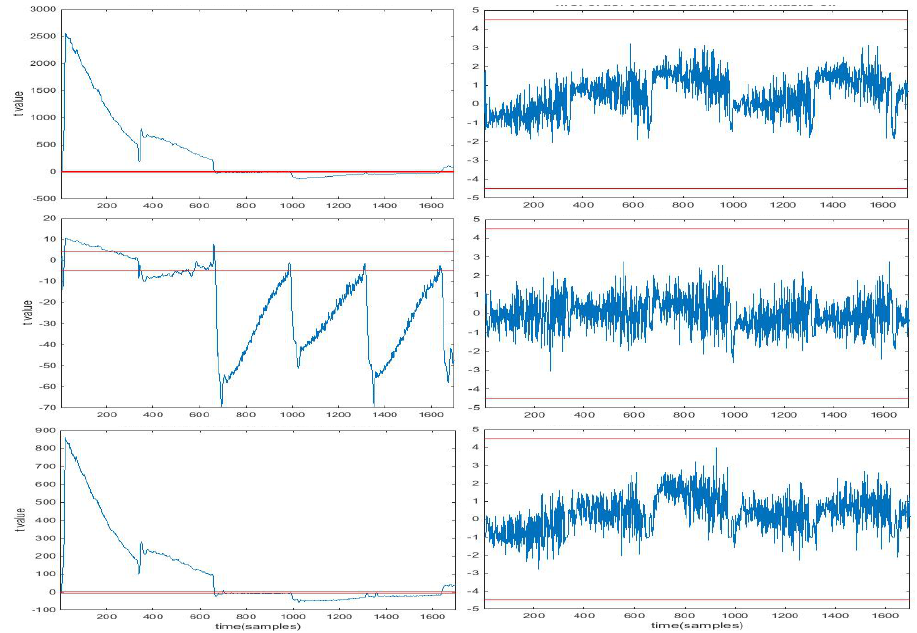
Figure 7: TVLA on first-order secure double round Keccak implementation. Left: Masks off. Right: masks on. From top to bottom: first-, second- and third- order